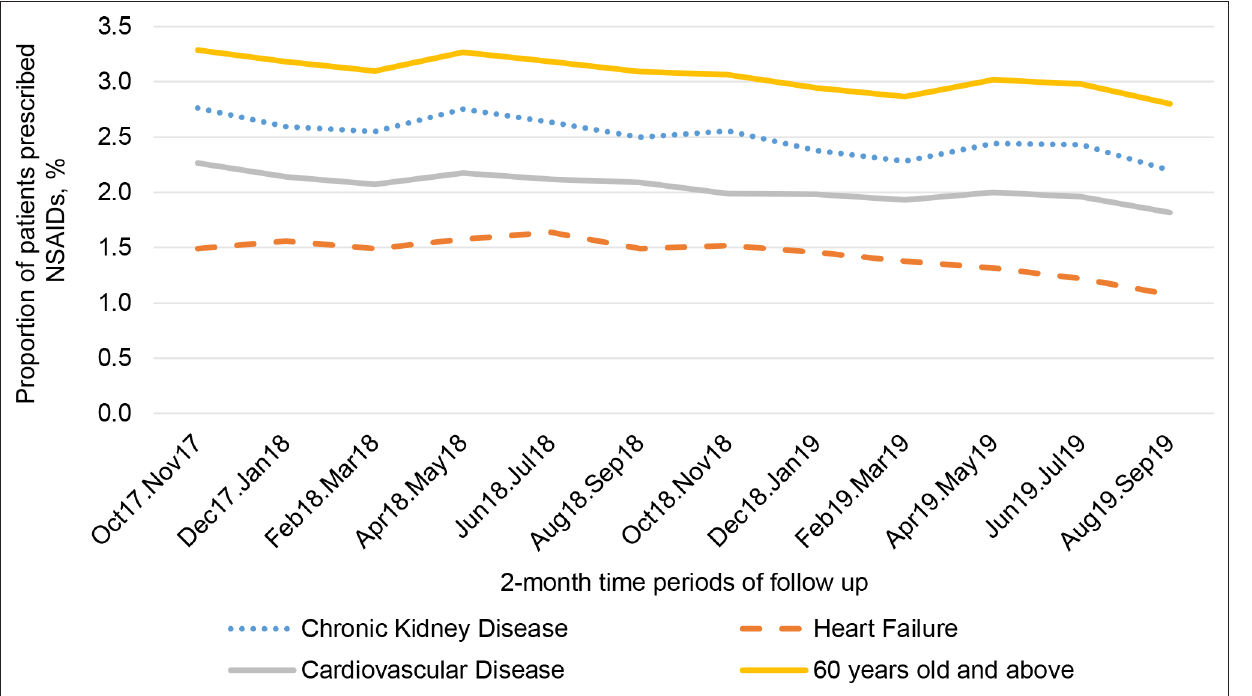
Figure 2 Proportion of patients in each of the risk groups prescribed NSAIDs in each 2- month time period of follow